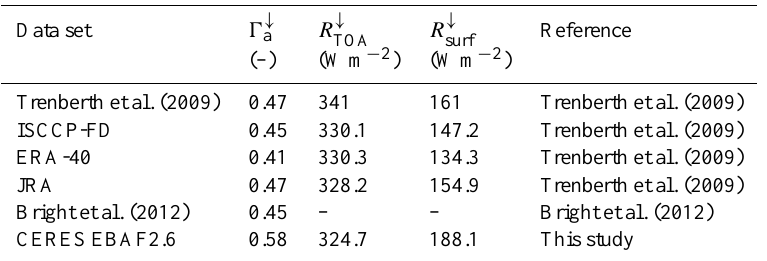
Table 2. Summary of atmospheric one-way or two-way transmissivity as derived from different sources. Input fluxes used for the transmis- sivity estimates are provided. Values are for land areas